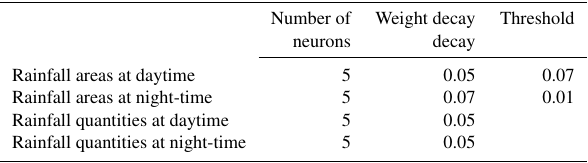
Table 1. Optimal hyperparameters for the individual models re- vealed during the tuning study and applied in the final model fitting.